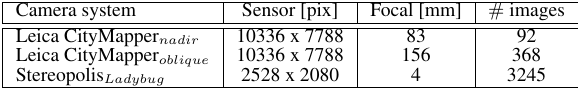
Table 1. Characteristics of the cameras used in the experiments. Aerial dataset (Leica CityMapper). This dataset (Toschi et al., 2018) is composed of 460 images (92 nadir images and 368 oblique images) collected by the Leica CityMapper hybrid sensor over the city of Heilbronn, Germany (data courtesy by Leica Geosystems). Leica CityMapper combines a Hyperion LiDAR unit (1064 nm wavelength, theoretical ranging